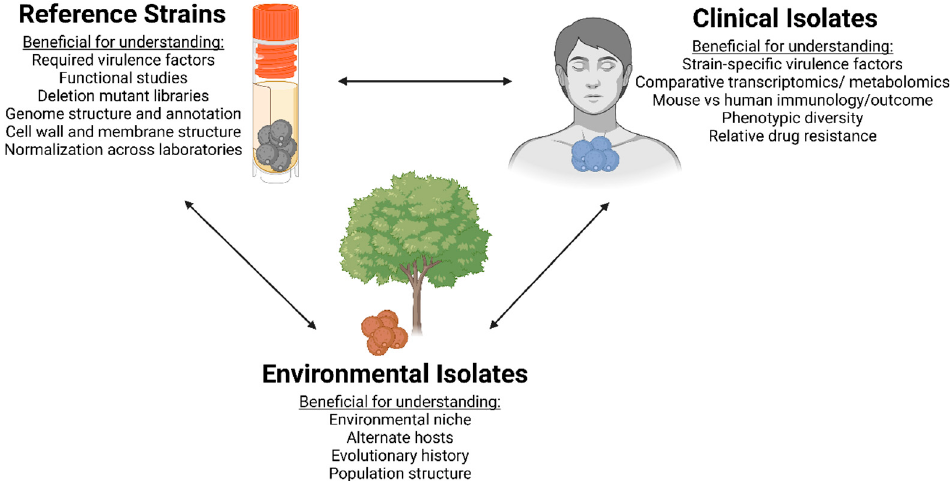
Figure 1. References strains, clinical isolates, and environmental isolates are beneficial for studying various aspects of Cryptococcus